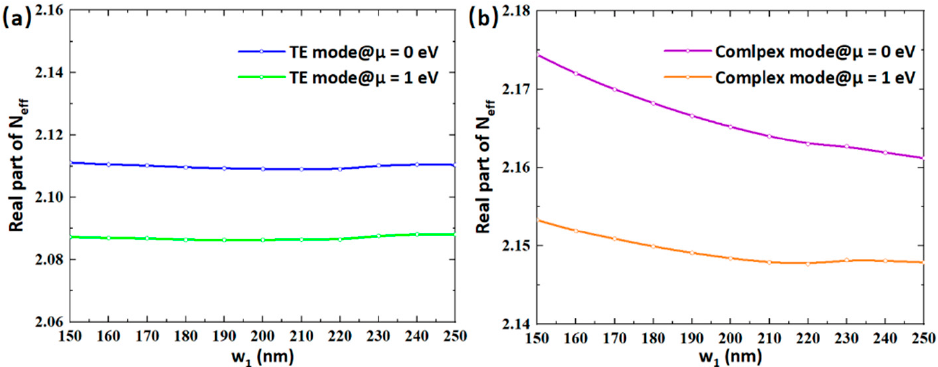
Figure 4. Re( N eff ) of ( a ) TE mode and ( b ) complex mode as a changing relationship of w 1 .